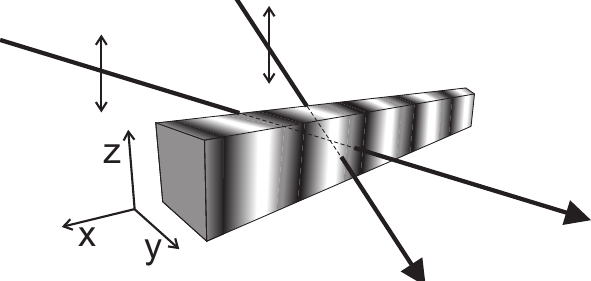
Figure 1. DR1 dye attached to the polymer chain ( left ) and model of chain with dyes, based on bond fluctuation model ( right ). Dyes nearly perpendicular to the light polarization direction do not undergo photoisomerization transition.